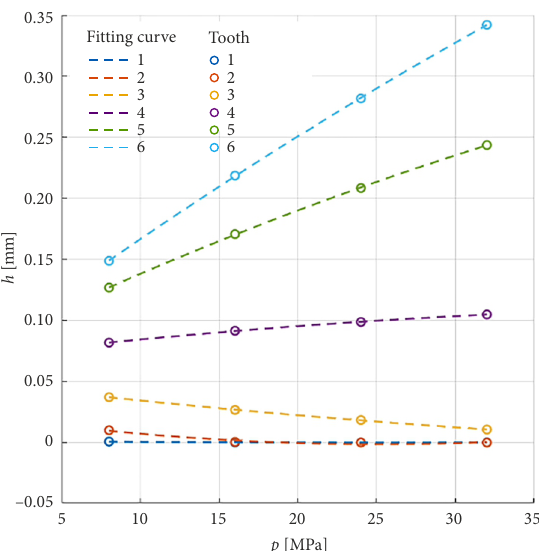
Figure 6. Change of mean gap height as a function of the pressure for the driven gear together with fitting curves